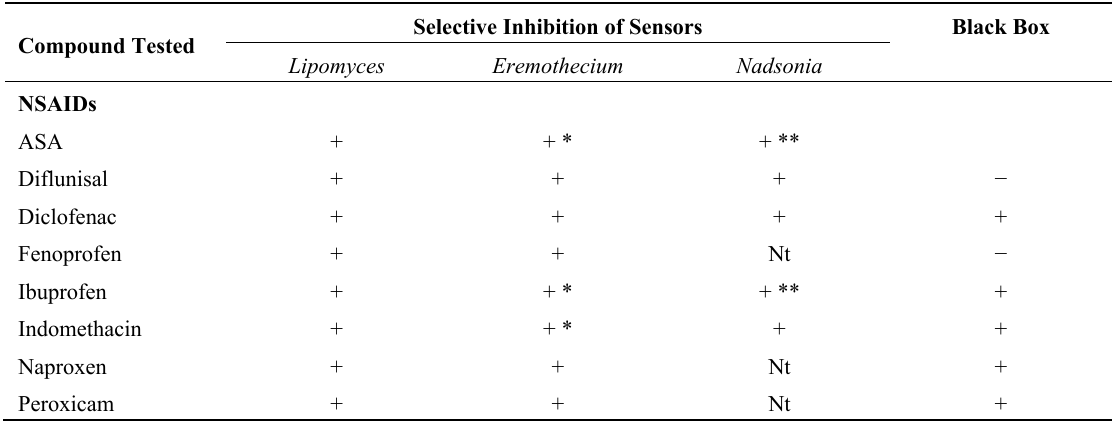
Table 1. Compounds screened with the colour sensors of Lipomyces , Eremothecium and Nadsonia , and compared to the Food and Drug Administration (FDA) Black Box Warnings for mitochondrial liabilities of drugs in use